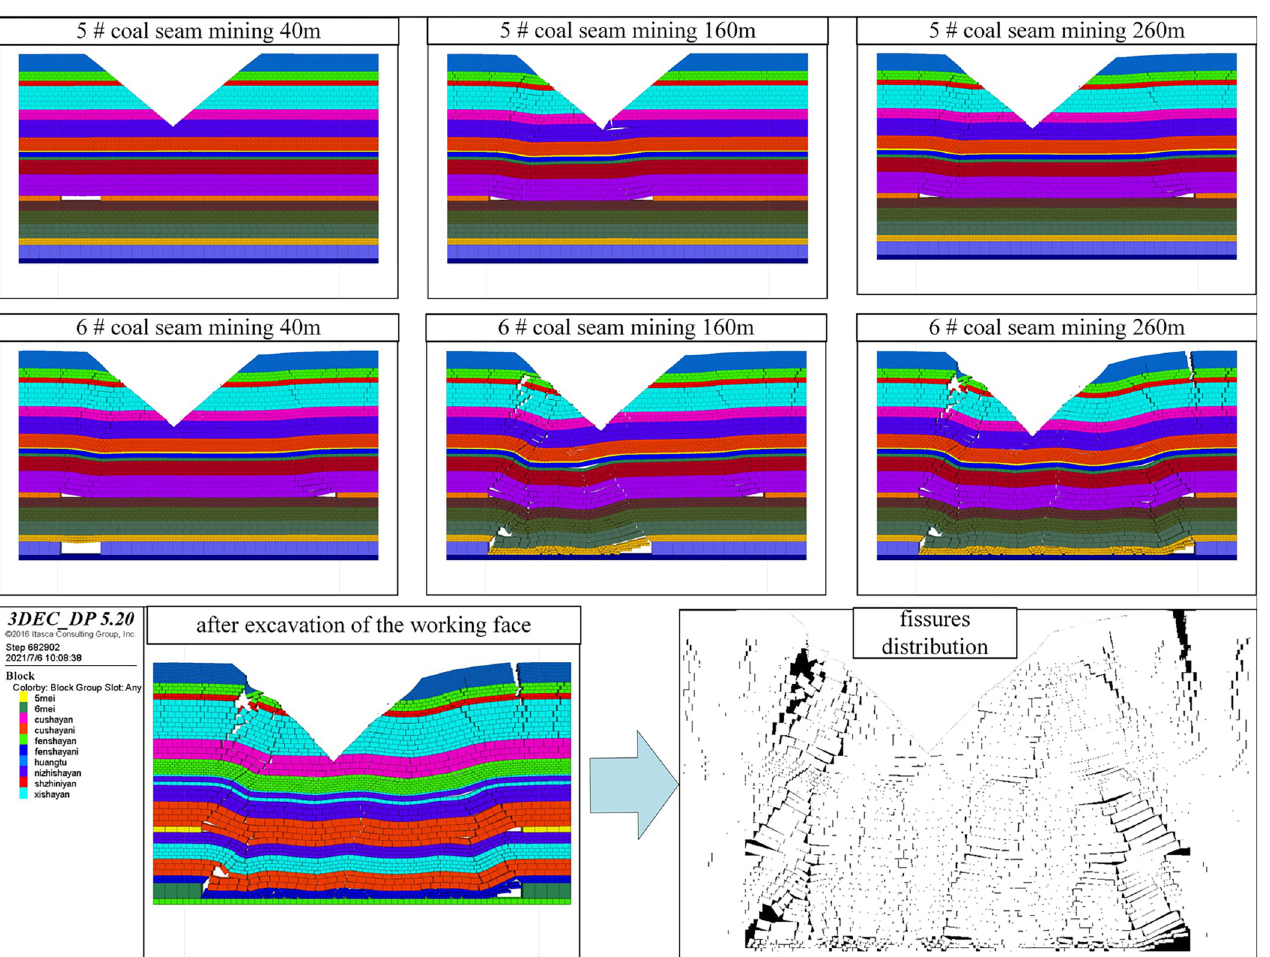
Fig 6. Schematic diagram of model